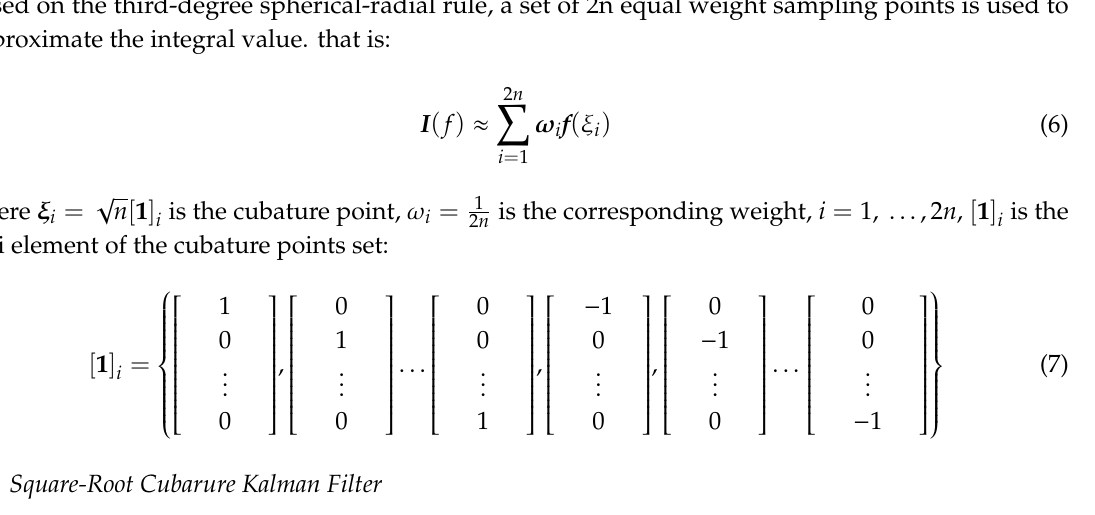
Speed resolution Speed –50–55 / (m / s) –50–55 / (m /